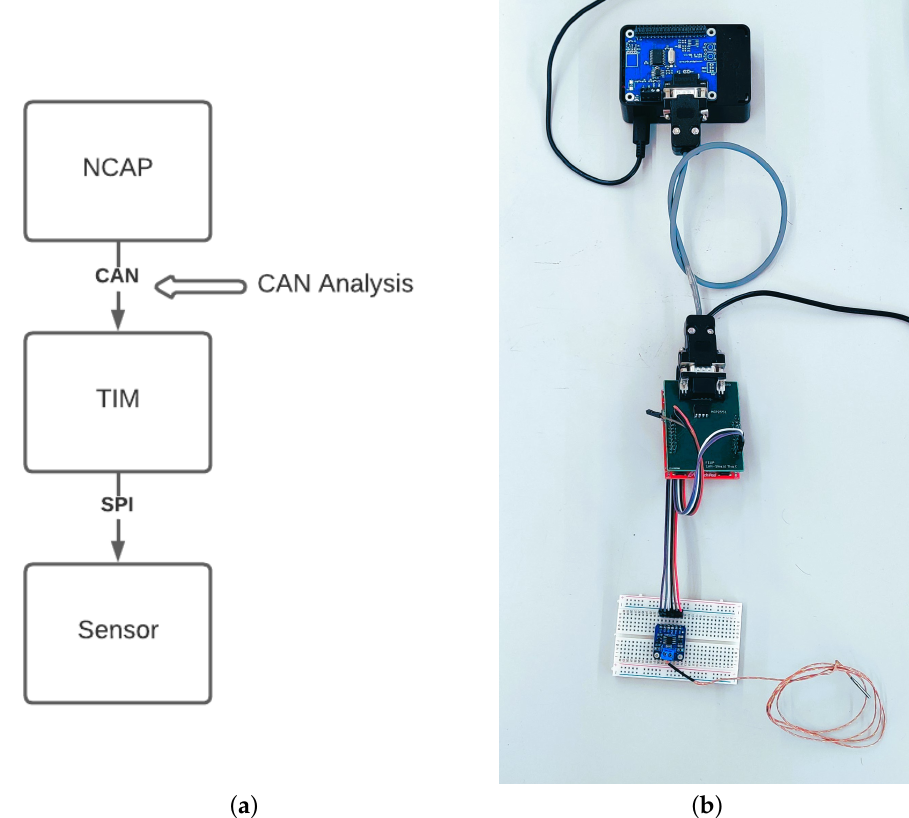
Figure 10. One-to-One-to-One System: ( a ) Diagram representing one-to-one-to-one system connec- tion; ( b ) Physical representation of the connected one-to-one-to-one